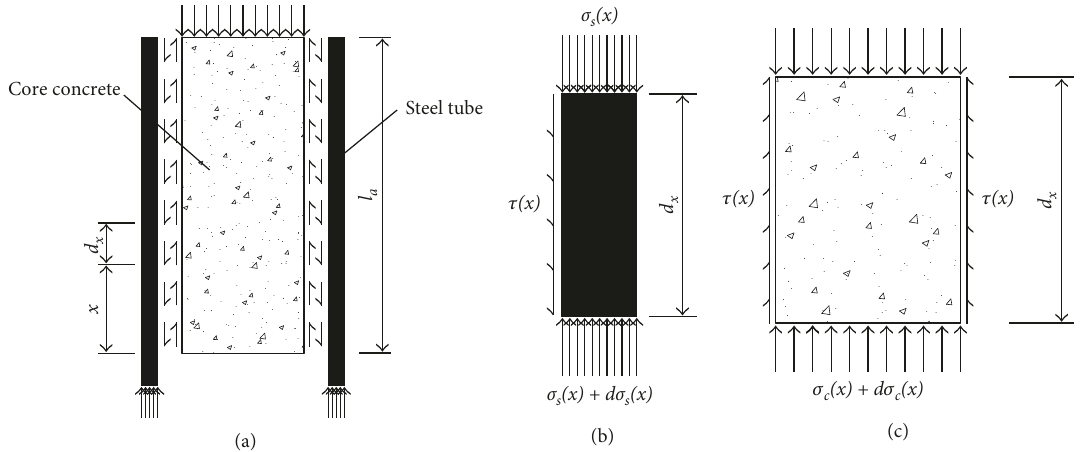
Figure 10: Stress analysis of the CFSSTs: (a) interaction between the steel tube and the core concrete; (b) equilibrium of a small element of the steel tube and (c) the core